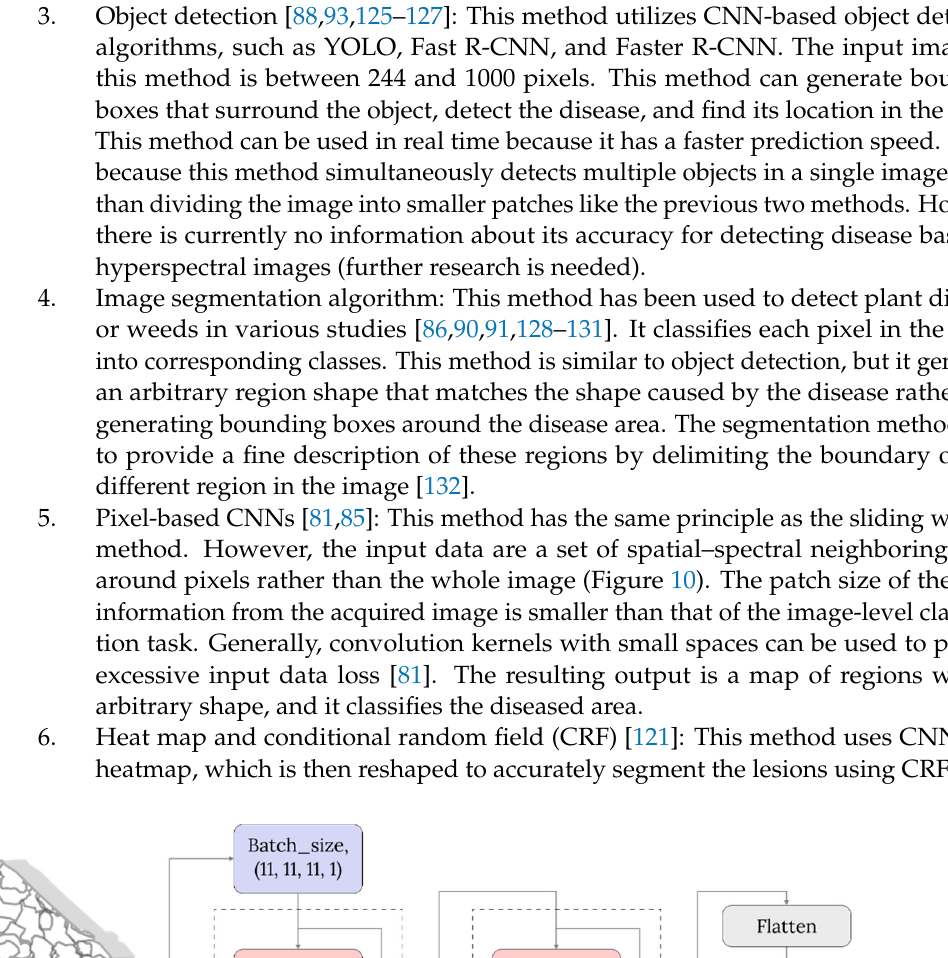
Table 2. Summary of the different methods for disease detection. Plant